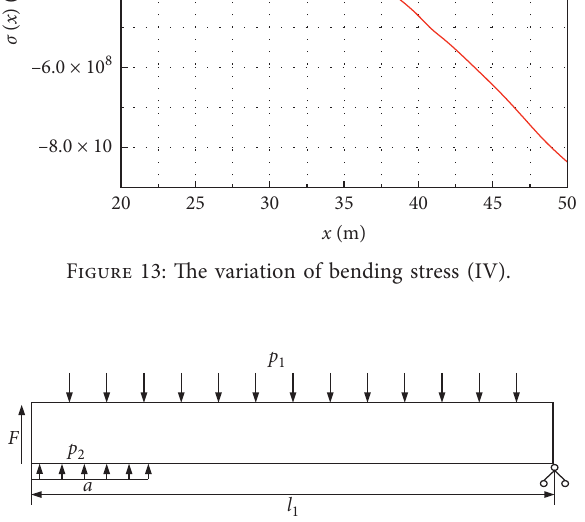
Figure 14: The mechanical model of reverse direction fault (the periodical fracture).